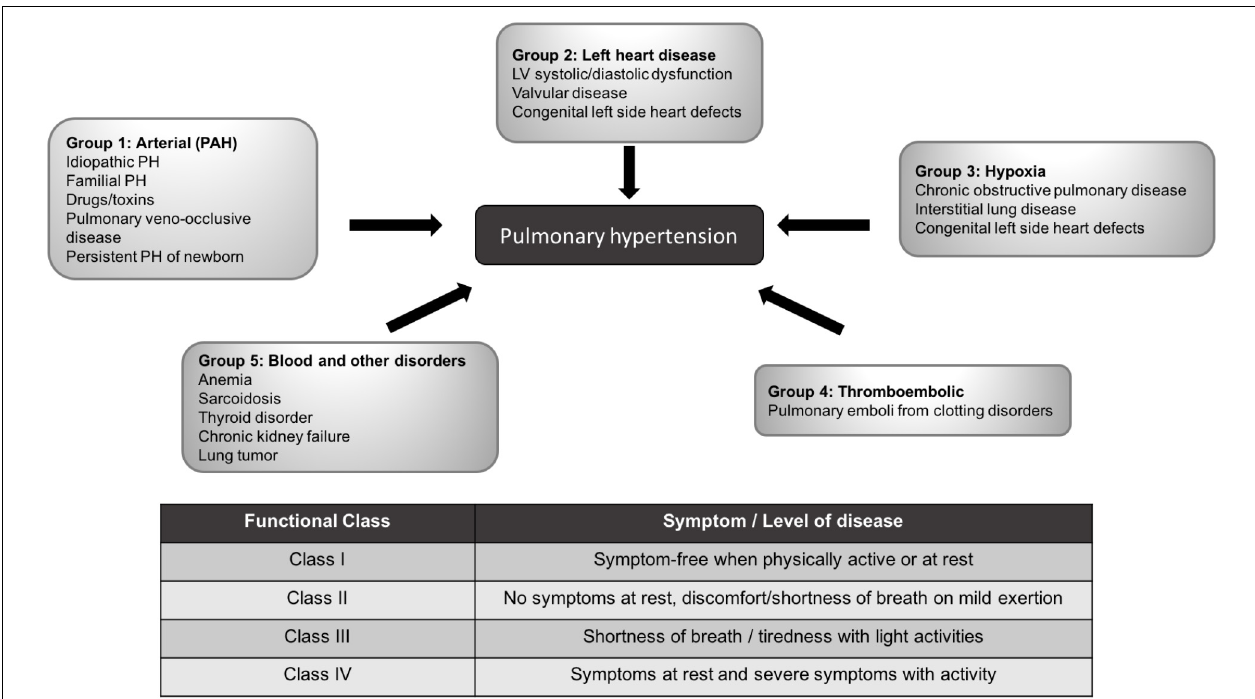
FIGURE 1 | PH World Health Organization classification and functional class. Five different major sub-types of PH according to World Health Organization classification and functional classes are out-lined. Adapted from (Humbert and McLaughlin, 2009; Galie et al.,